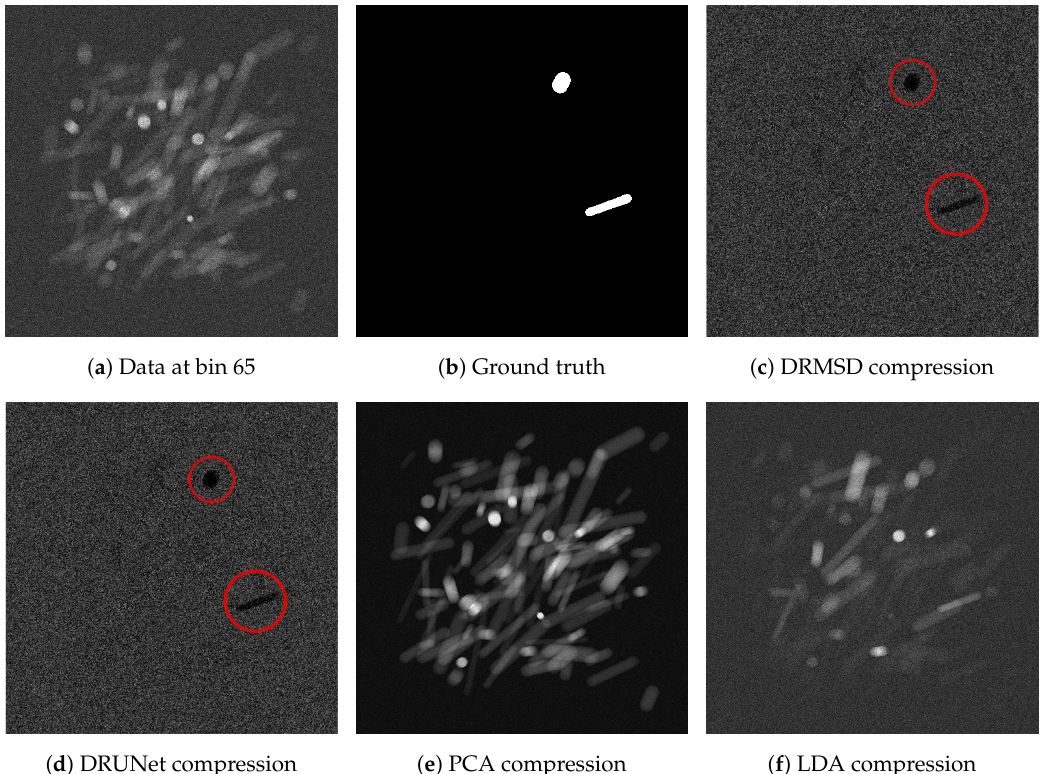
Figure 17. Visual comparison of the data reduction methods for reduction of the noisy many material dataset ( a , b ) to 1 image. Despite the high noise, DRMSD ( c ) and DRUNet ( d ) create the most distinctive images with respect to the ground truth (note the dark shapes at the target cylinder locations, indicated by red circles). The PCA ( e ) and LDA ( f ) compressions are included, but the Nonnegative Matrix Factorization (NMF) compression is omitted, as it is highly similar to the PCA compression.